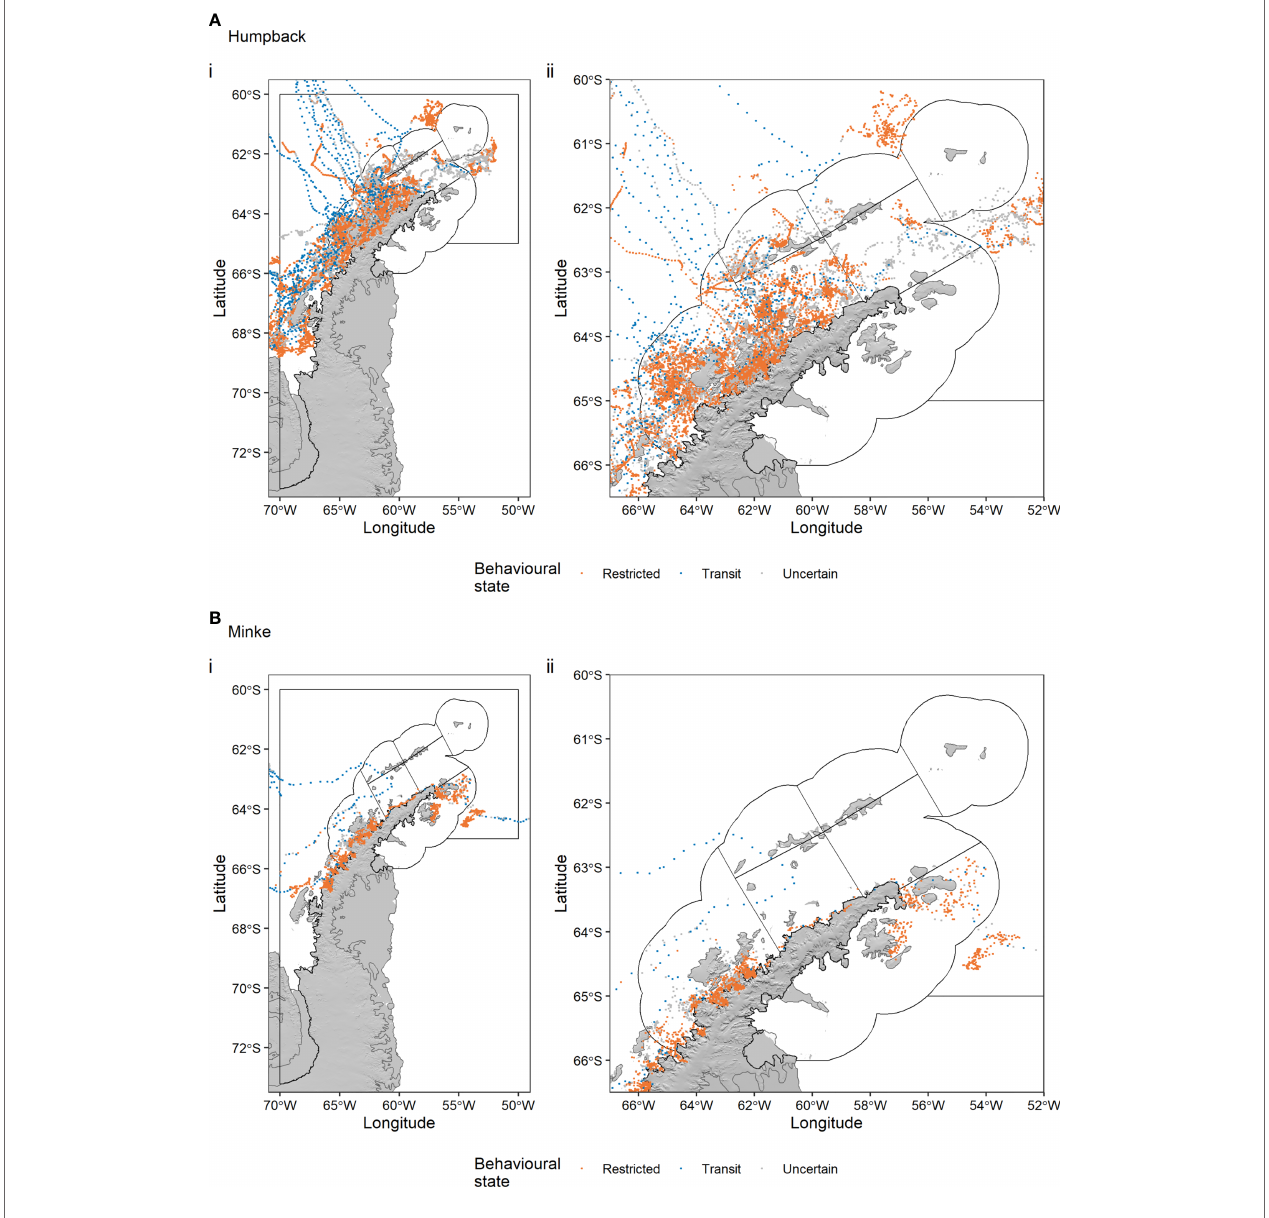
FIGURE 2 | Humpback whale (A) and minke whale movement (B) tracks off the Antarctic Peninsula. A behaviour switching state-space model was used to regularise the locations in time (6-hour timestep), to account for errors associated with satellite tracking data, and estimate the behavioural state of whales. Black polygons indicate the seven CCAMLR Small Scale Management Units (SSMUs) within Subarea 48.1, which is delineated by the outer black